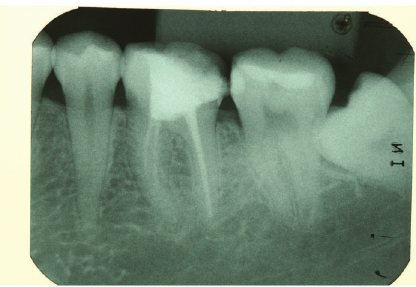
Figure 2: Initial radiography indicates that the molar was endodon- tically treated.